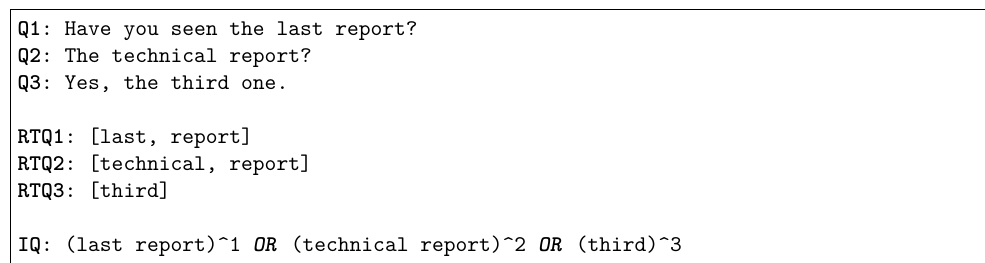
Figure 2. Implicit query formation, based on the disjunction of the extracted context entries (relevant tokens), boosted with its recency.